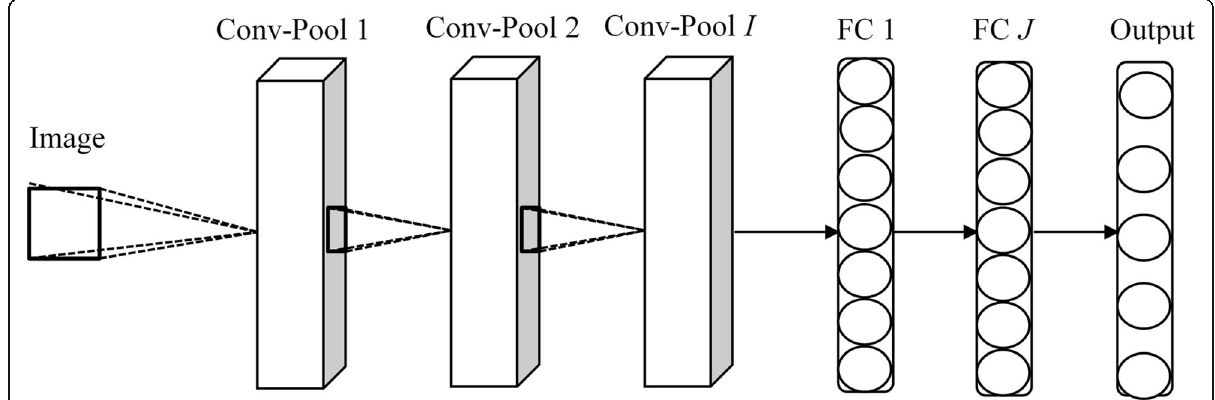
Fig. 1 Deep convolutional neural network (DCNN) architecture for face